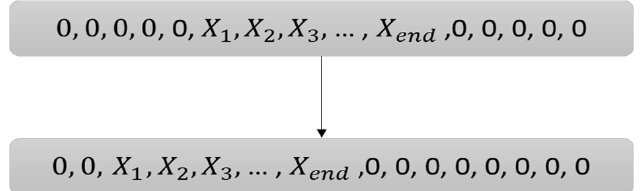
Figure 6. Lag consideration in feature vector in finite support signal.